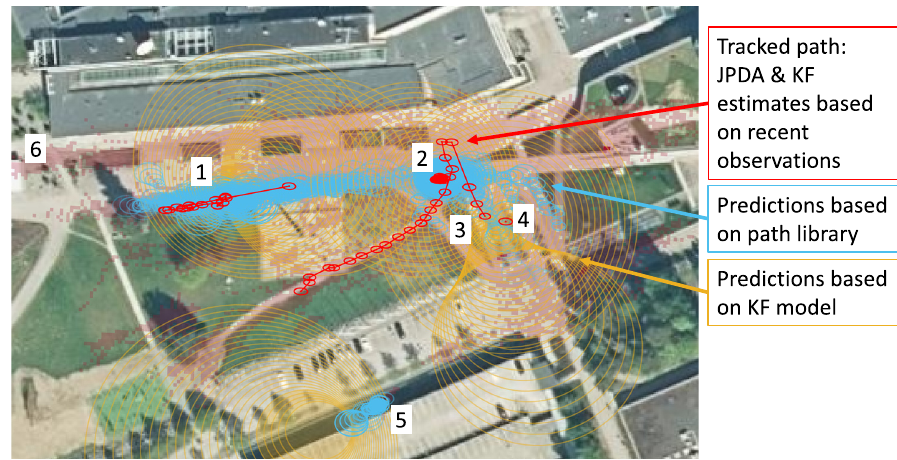
Figure 8: Real data example: path tracking and predictions with KF and path library.